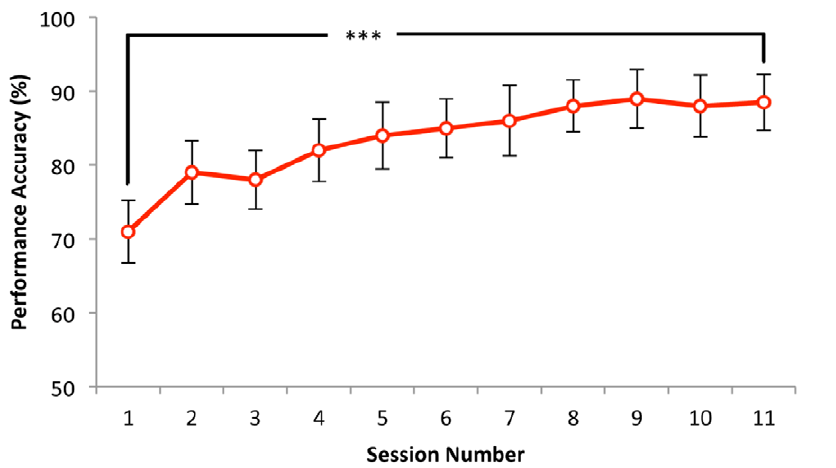
Figure 4. Performance accuracy of the training group on numerosity judgement task during 11 training sessions. *** p , 0.001.